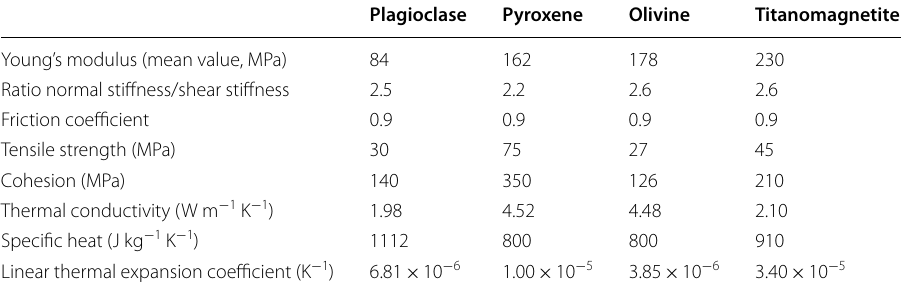
Table 2 Mechanical, thermal and thermo-mechanical